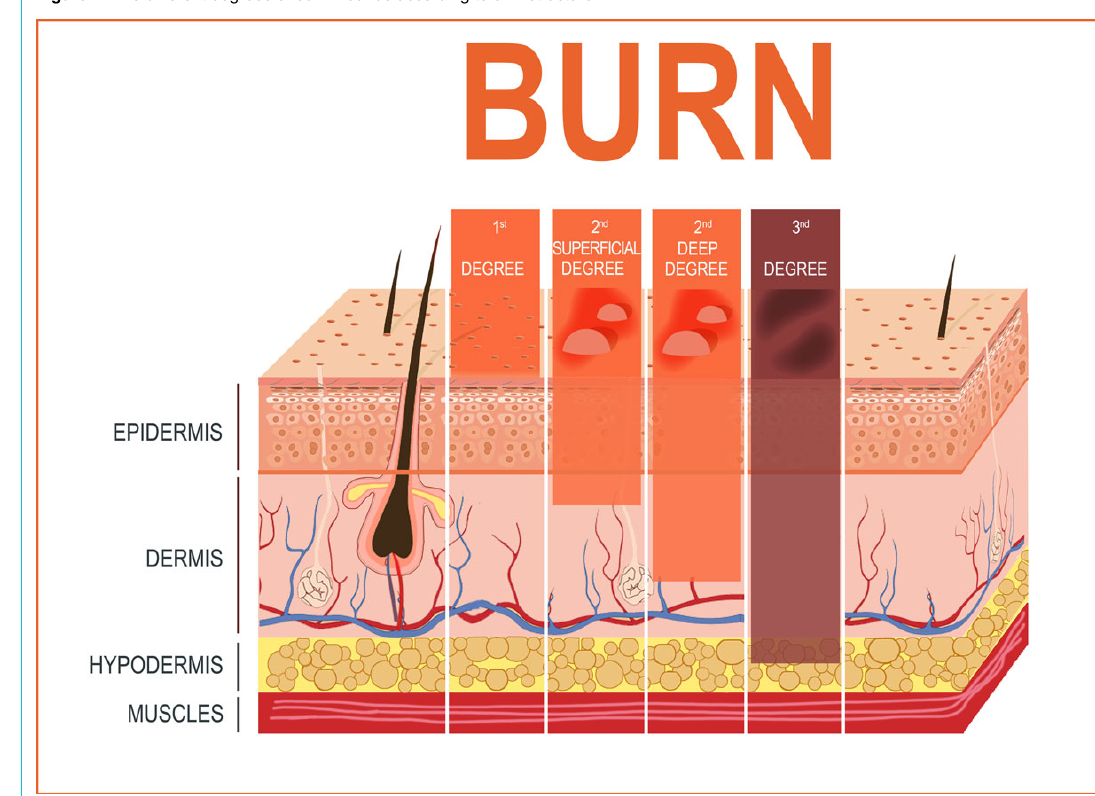
Figure 1: The different degrees of burn wounds according to skin